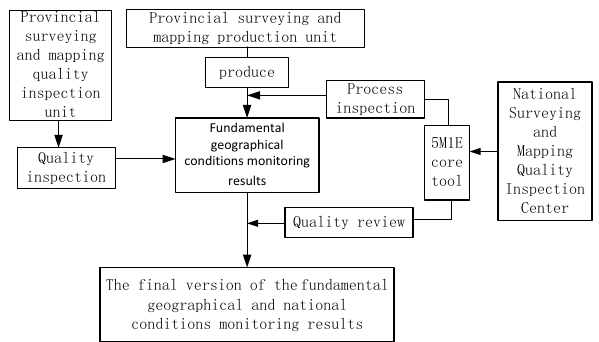
Figure 5. Fundamental geographic national